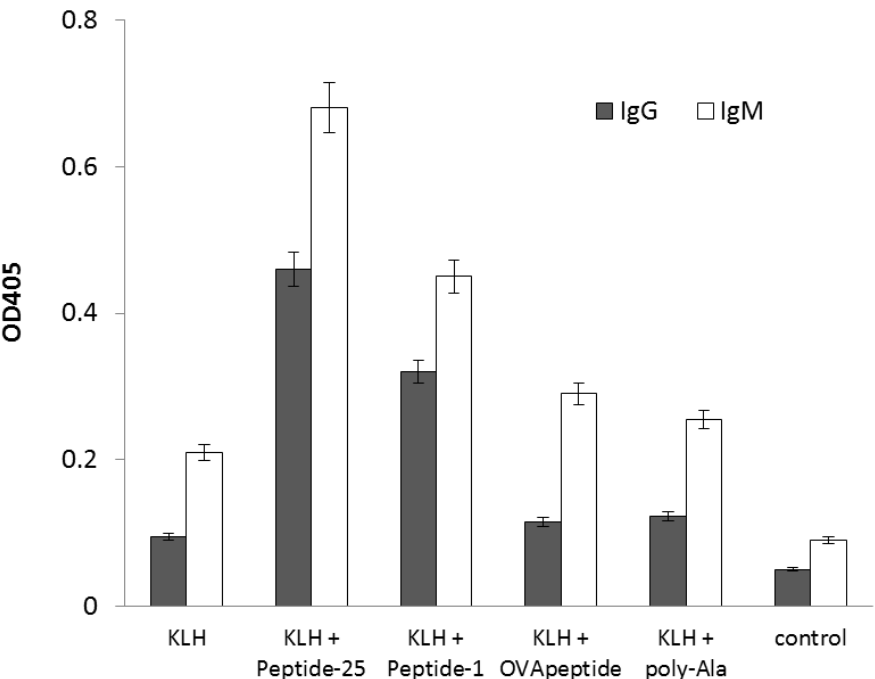
Figure 3. Induction of antigen-specific IgG by IVI in the presence or absence of agretope peptide. Both antigen-specific IgG and IgM were measured. Peptide-25 denotes a 15-mer peptide derived from Ag85B of M. tuberculosis . Peptide-1 denotes peptide RGIFFYVFAAYKEI, a 14-mer with the highest score from in silico screening. OVApeptide denotes peptide RGISQAVHAAHAEI, corresponding to amino acid residues 323–339 of ovalbumin. Poly-Ala denotes a control peptide composed of 15 alanines. Control denotes IVI without added antigen. Columns represent the average of three independent experiments, and error bars represent the standard deviation.